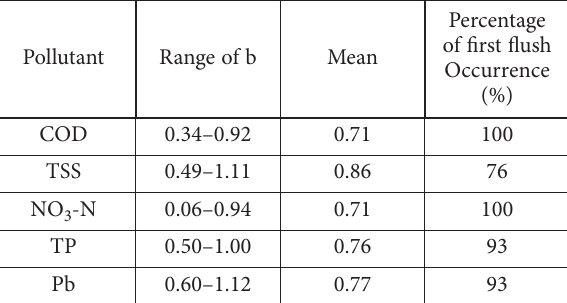
Percentage of first flush Occurrence (%)